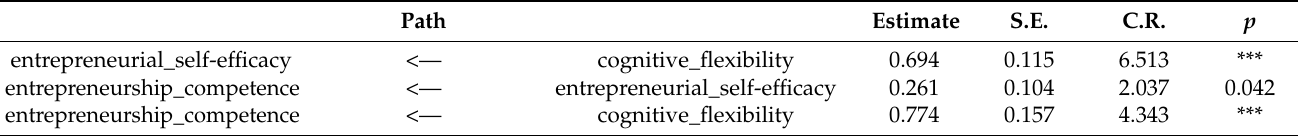
Table 6. Path analysis.